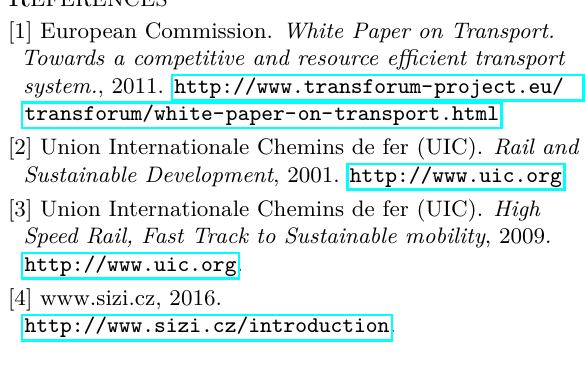
nical state of vehicles, service speed, running dynamic, track structure, track quality, track alignment, geo- logical parameters,